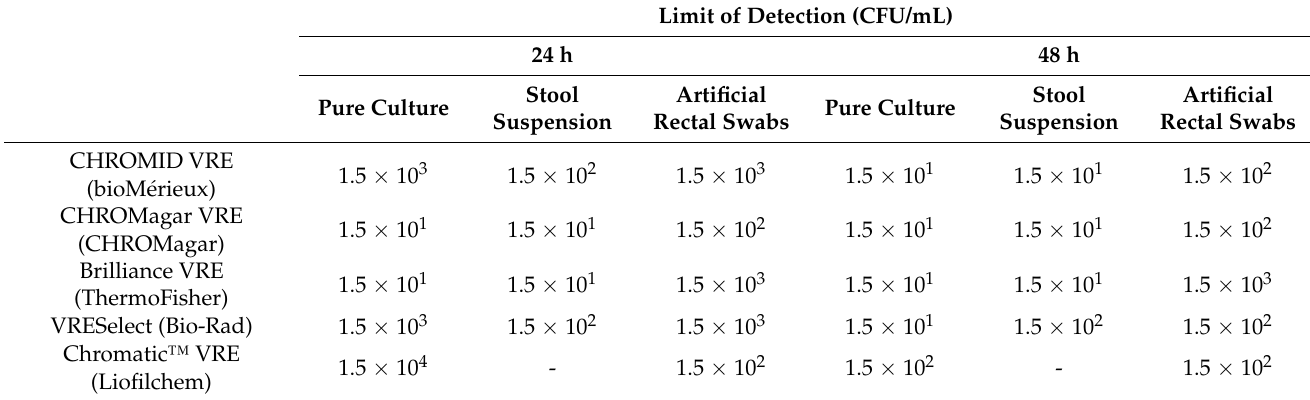
Table 3. Limit of detection of the different selective agars